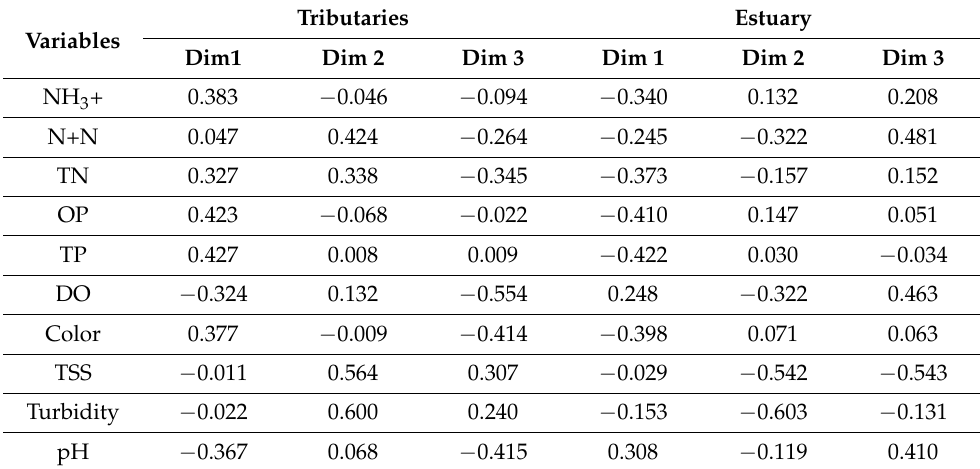
Table 4. Variable loadings to the first three